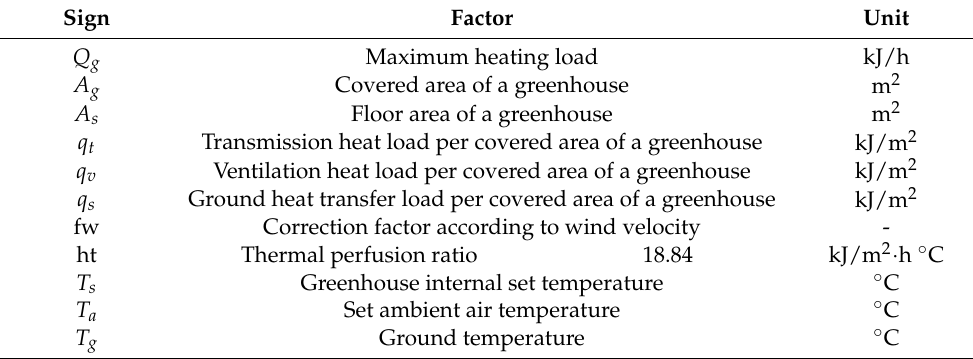
Table 6. Factors required to calculate the heating